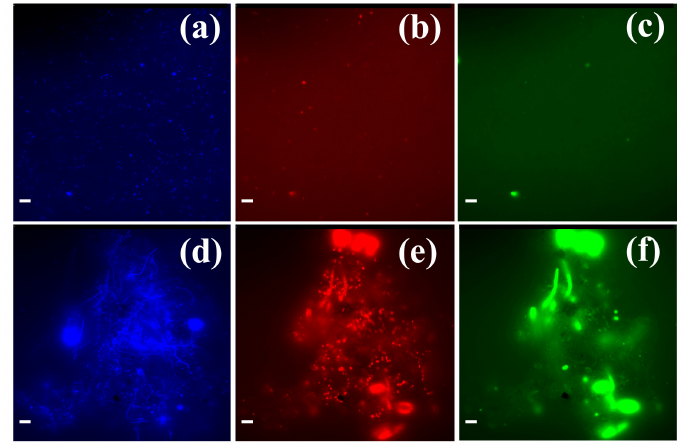
Figure 3. Representative images of free-living bacteria; ( a ) DAPI-stained for total cells (indicated in blue), ( b ) both Chl a -positive (cyanobacteria, autotrophic nanoflagellate and eukaryotic phytoplankton) and BChl a -positive (AAnPB) cells (indicated in red) and ( c ) Chl a -positive (cyanobacteria, autotrophic nanoflagellate and eukaryotic phytoplankton) cells (indicated in green). Those of particle-attached bacteria; ( d ) DAPI-stained for total cells (indicated in blue), ( e ) both Chl a -positive (cyanobacteria, autotrophic nanoflagellate and eukaryotic phytoplankton) and BChl a -positive (AAnPB) cells (indicated in red) and ( f ) Chl a -positive (cyanobacteria, autotrophic nanoflagellate and eukaryotic phytoplankton) cells (indicated in green). Each scale bar indicates 7 µ